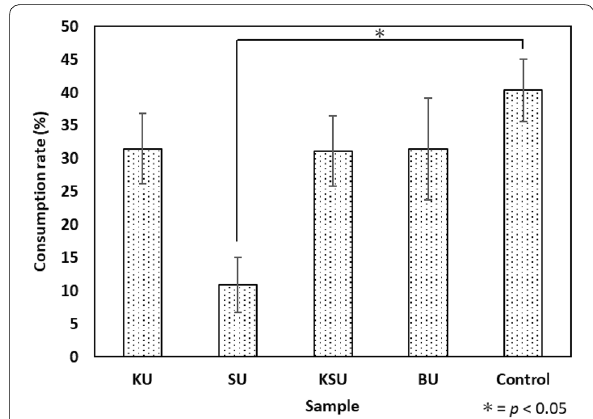
Fig. 4 Mass losses in the samples after a 3-week no-choice termite feeding test (mean S.D). * p < ±